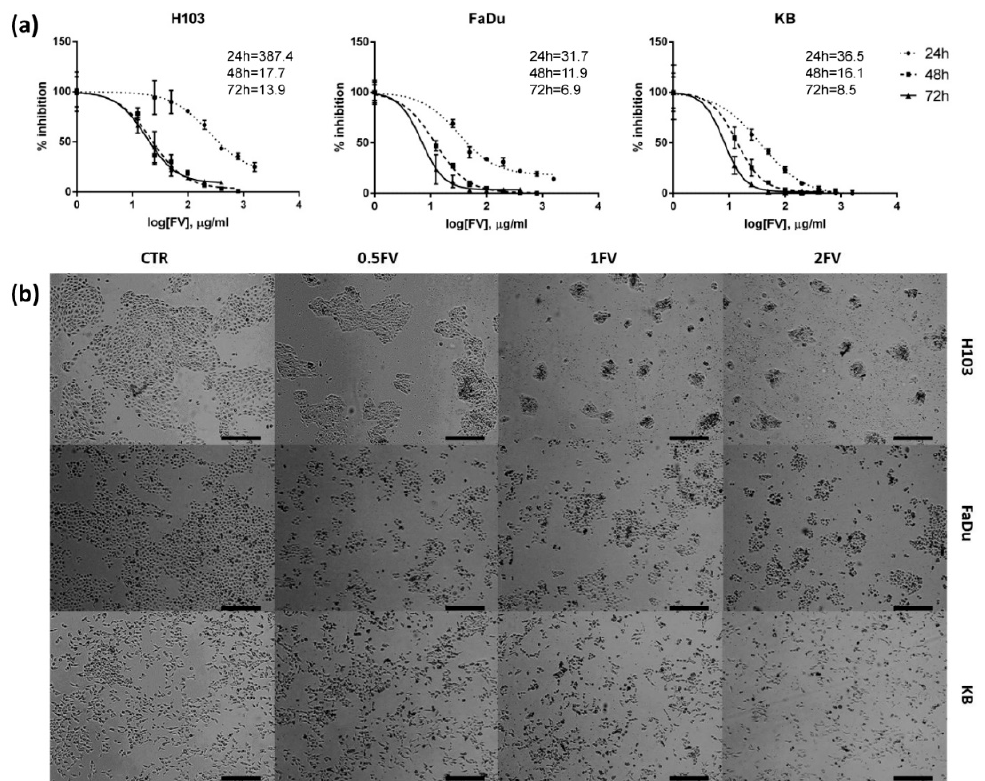
Figure 1. Effect of fucoidan on the proliferation and viability of HNSCC cell lines: H103, FaDu, KB. ( a ) Inhibition of proliferation of tested cell lines after incubation with fucoidan for 24, 48 and 72 h. The data are presented as a mean ± standard deviation. ( b ) The decreased proliferation of tested cell lines after 24 h incubation with different concentrations of fucoidan was observed (CTR—control, 0.5FV—half-fold of IC50 concentration, 1FV—IC50 concentration, 2FV—2-fold of IC50 concentration). Pictures were taken under 40 × magnification. Scale bars represent 200 µ